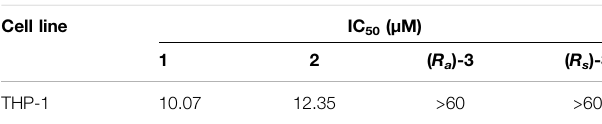
TABLE 3 | Cytotoxicities of compounds 1 –